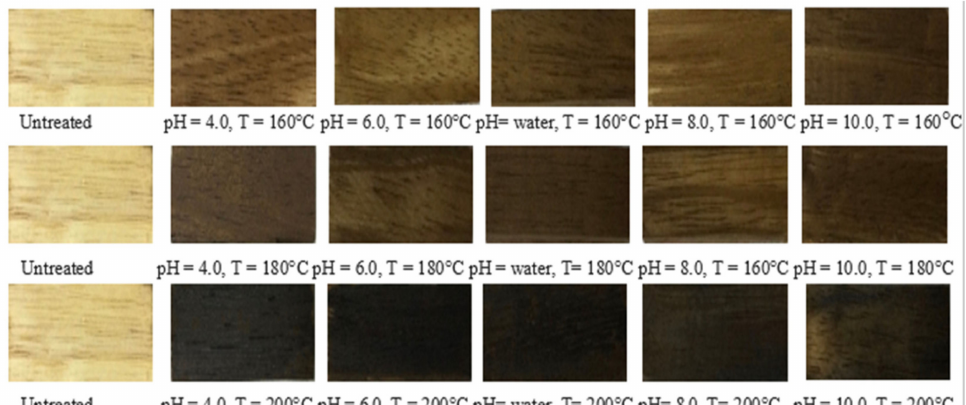
Figure 3. Visual observation of the color changes of untreated and hydrothermally treated rubber- wood